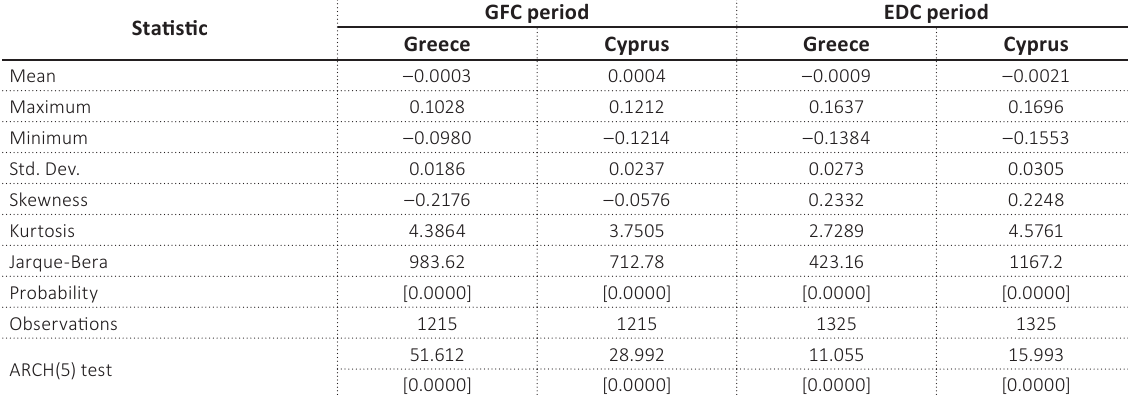
Table 1. Descriptive statistics – Global Financial Crisis and Eurozone Debt